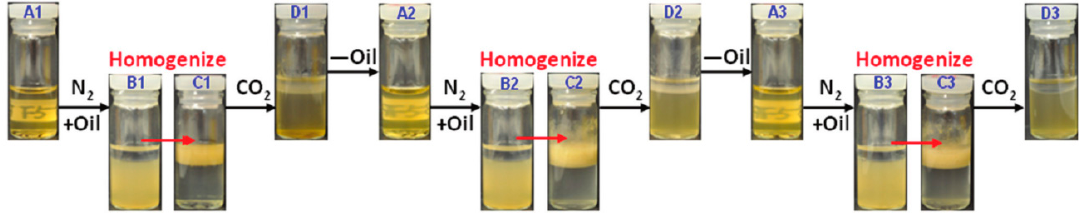
Figure 7. Illustration of three cycles of CO 2 -triggered emulsification and N 2 -triggered demulsification of lignin-g-DEAEMA water/decane Pickering emulsion. Reproduced from [92] with permission of The Royal Society of Chemistry.